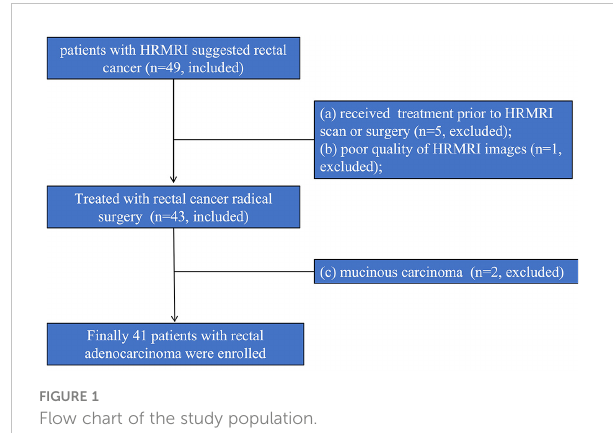
FIGURE 1 Flow chart of the study